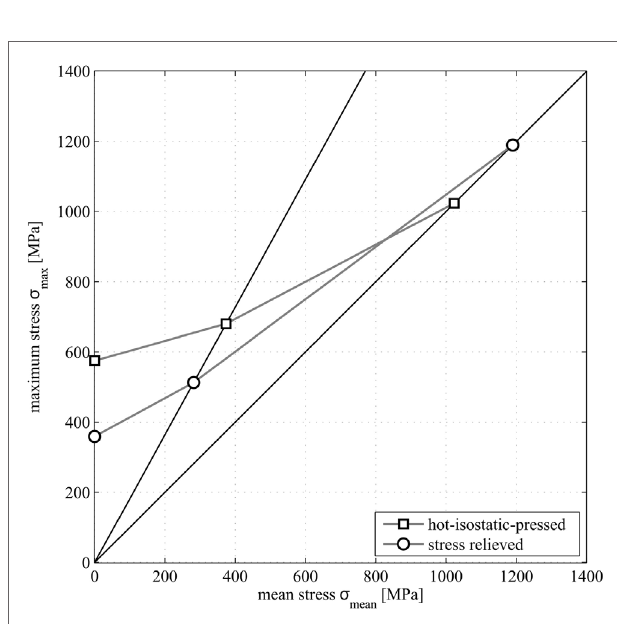
FigUre 9 | smith diagram for stress-relieved and hot-isostatic- pressed additive manufactured Ti–6al–4V